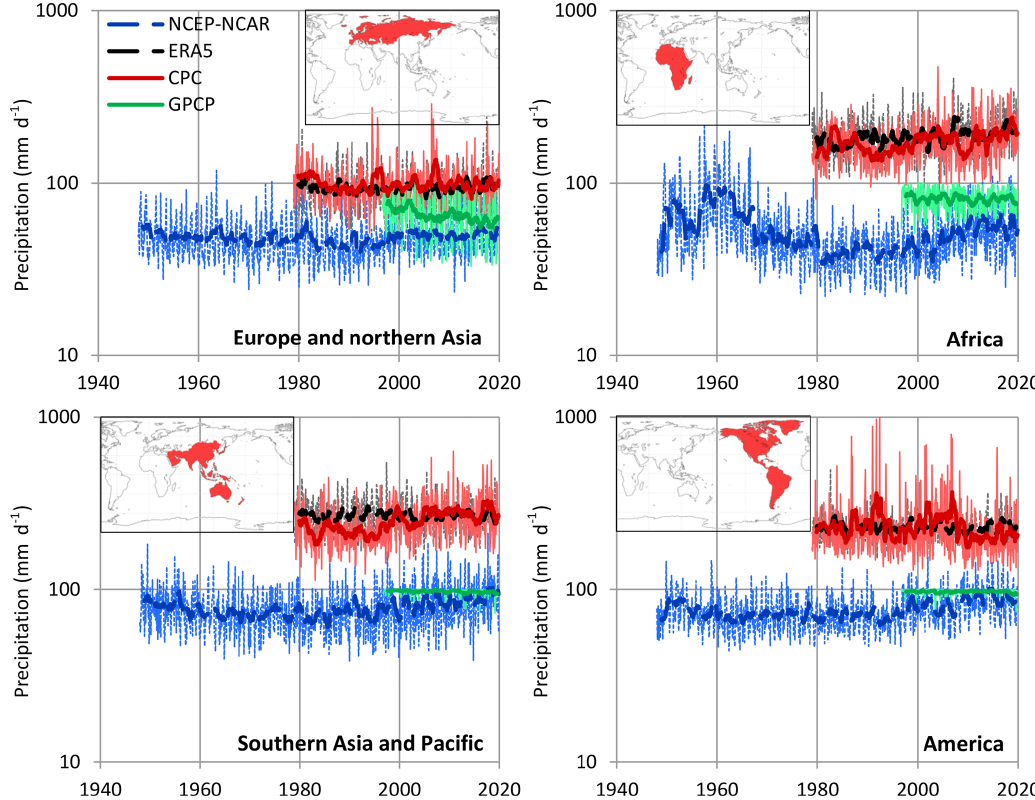
Figure B2. Variation of the areal maximum, over each continent, monthly maximum daily precipitation. Thin and thick lines of the same colour represent monthly values and running annual averages (right aligned), respectively. Dashed lines are for reanalyses and continuous lines for observations. Sources of the data are indicated in the legend and detailed in Table 1. Notice that the satellite (GPCP) data do not seem to capture precipitation rates higher than 100mmd − 1 .